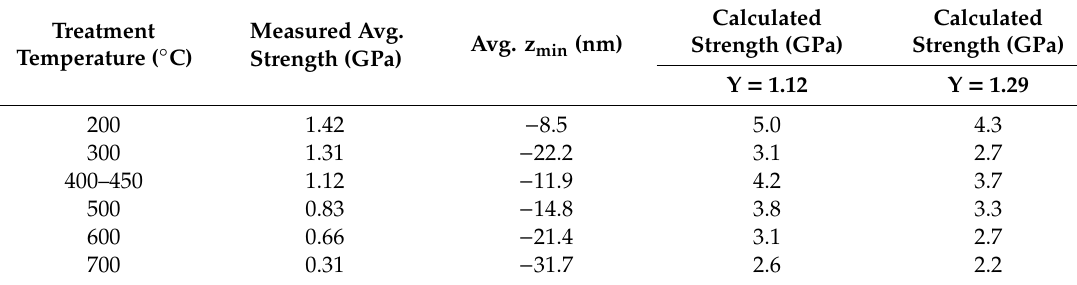
Table 3. Comparison of measured average strengths of heat-treated fibres, with calculated strengths based on z min values taken from AFM topography of heat-treated